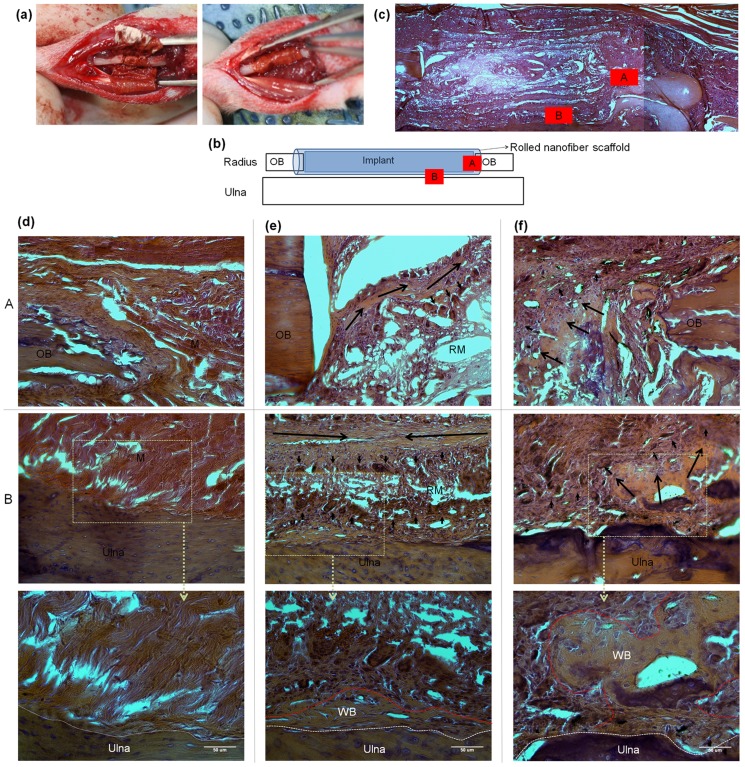
Imaging and histologic analyses of MNPs.(a) Image showing a rat radial segment model; radial segment was removed and then nanofiber scaffold was placed underneath and then rolled to cover the defect region, providing a columnar radial space while preventing soft tissue invasion into the defect region, and the implantation system was schematically drawn in (b), showing relation between outer rolled scaffold, and bone tissue integration within a defect area in radius and the unla in proximity to the scaffold. (c) Representative H&E stained histologic appearance made at 8 weeks after operation. Histologic analysis was made in the regions ‘A’ and ‘B’, and presented in (d) control group free of scaffold, (e) pure PCL scaffolding group, and (f) 15MNP scaffolding group. Enlarged images of bracket regions in ‘B’, showing the new bone formation (woven bone (WB) structure similar to native ulna, and the area indicated as red dotted line). Abbreviations are OB: old bone of radius, M: muscle, RM: remained material, WB: woven bone. Black arrows: bone growing direction, black arrowheads: cell migration from new tissue into material part, white dotted lines: border of ulna and neo-tissue, and red dotted lines: area of WB.